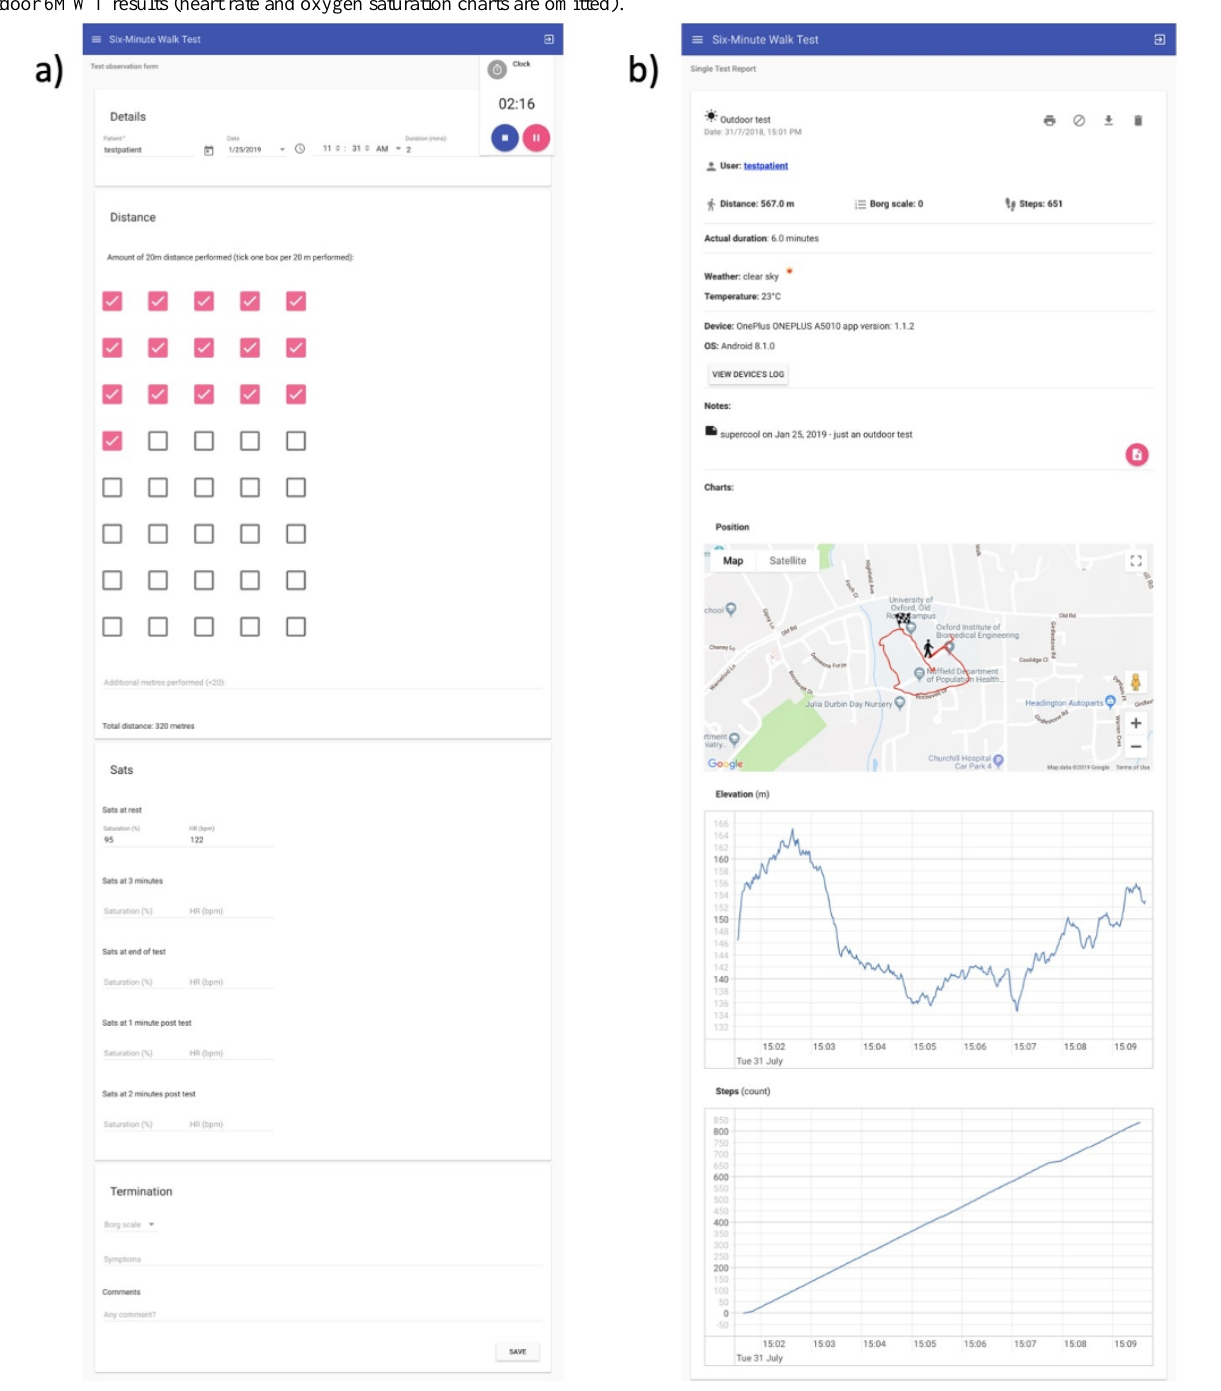
Figure 6. Screenshots of the server Web interface. (a) The form physiologists fill in when observing a 6-min walk test (6MWT), (b) an example of an outdoor 6MWT results (heart rate and oxygen saturation charts are